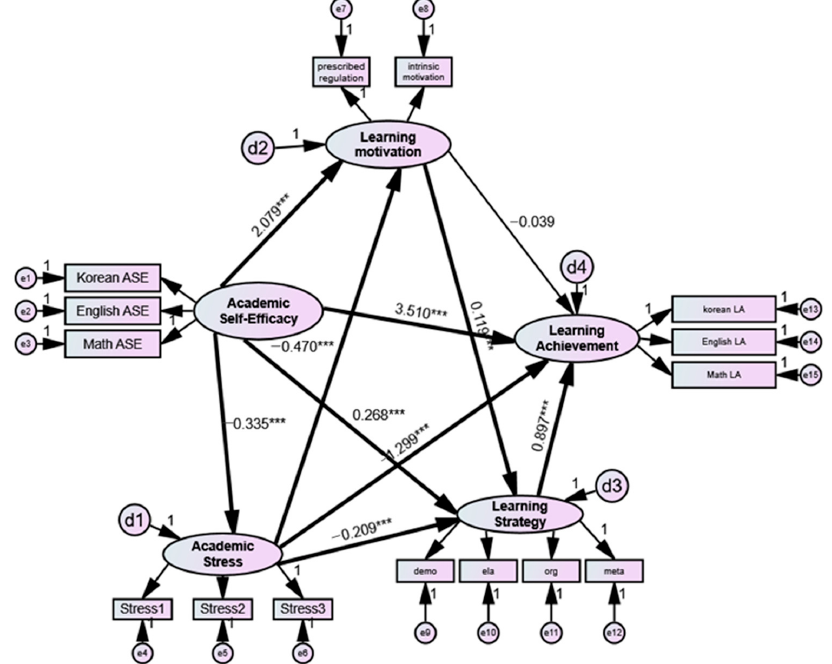
Figure 2. Middle school model showing academic stress, learning motivation, and learning strategy as mediating variables in the relationship between academic self-efficacy and academic achievement. Note : e = measurement error; d = structural error; ASE = academic self-efficacy; LA = learning achievement; stress1 = anxiety stress; stress2 = relationship stress; stress3 = competence stress; demo = demonstration; ela = elaboration; org = organization; and meta = meta-cognition. *** p < 0.001.